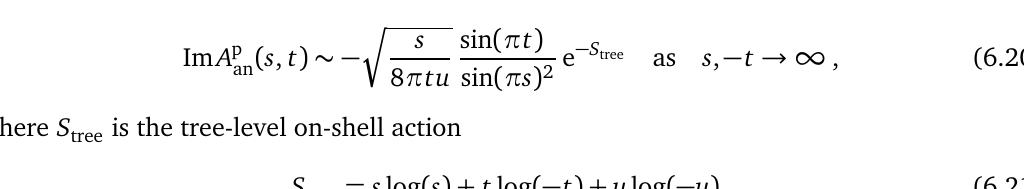
Figure 29: Imaginary parts of the partial wave coefficients f We observe that spins up to j always dominate the imaginary part up to s ≲ j + 1. A ( s ) has a double pole peak at a positive integer s = n only if n + j is odd, with given f j the exception of ( n , j ) = ( 3,0 )